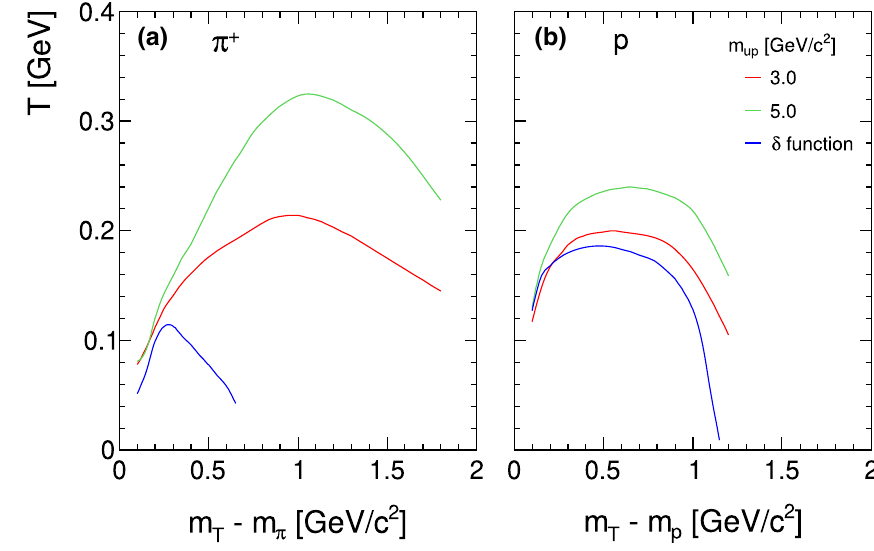
Fig. 173 Inverse slopes T of the m T distributions (a) for decay pions and (b) for decay protons from the Δ ++ resonance as a function of x F for different values of m